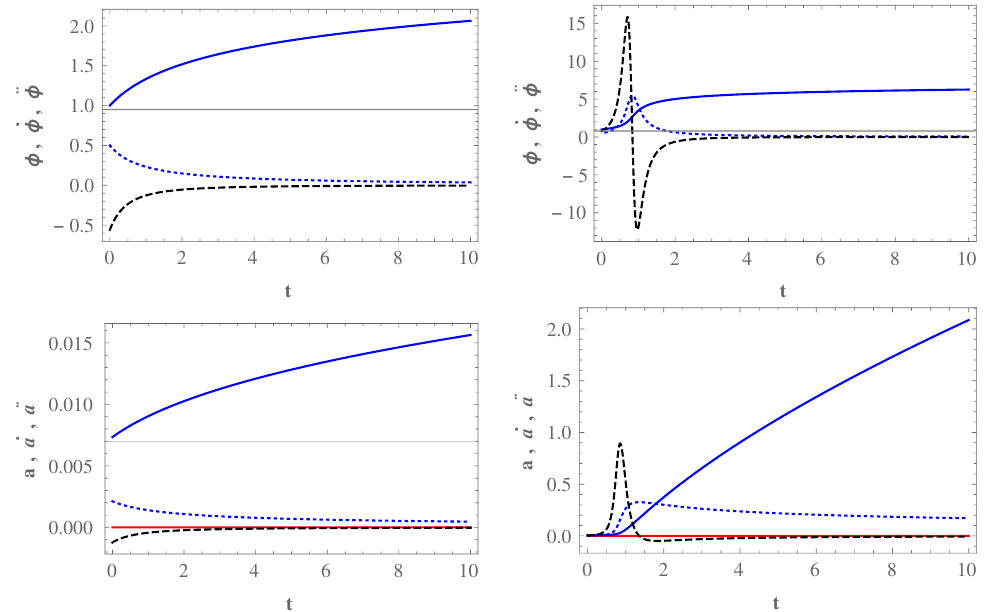
Figure 1. The behavior of the scalar field φ ( t ) and the scale factor a ( t ) (solid curves), their first and second derivatives (dotted and dashed curves, respectively) against cosmic time for the commutative model, for which θ = 0, ( the left panels ) and NC model with θ = − 0.001 ( the right panels ). Moreover, for both the commutative and NC models, we have set n = 1, W = 2, 8 π G = 1, a i = 0.005, φ i = 0.01, φ ( 0 ) = 1, ˙ φ ( 0 ) = 0.5. To recognize the quantities with positive and negative values, we have plotted a ( t ) = 0 with a red